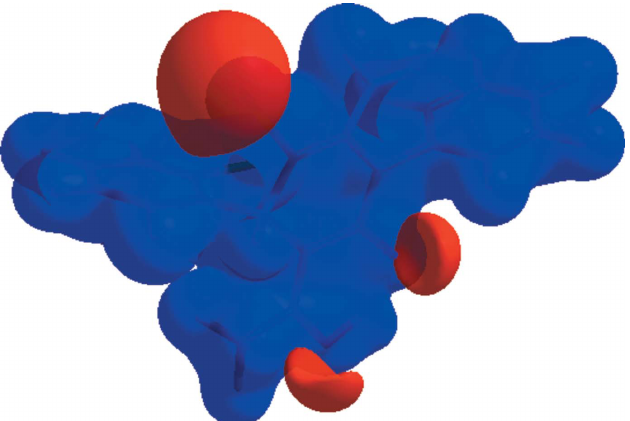
dimensional fingerprint plots generated using Crystal Explorer 17.5 (Turner et al. , 2017). The use of various hues and inten- sities to represent short and long contacts, as well as the relative intensity of the connections, allows Hirshfeld surfaces to depict intermolecular interactions. Fig. 4 shows the three- dimensional Hirshfeld surfaces of the title compound plotted over d (normalized contact distance) in the range of norm (cid:5) 0.4290 to 1.5192 a.u. The red patches that appear around N2 are caused by the intermolecular N3—H3 A (cid:2) (cid:2) (cid:2) N2 and C16— H16 (cid:2) (cid:2) (cid:2) N2 interactions, which are important in the packing of the title molecule. Bright red dots near N2 and amine hydrogen atoms H3 A and H3 B highlight their functions as hydrogen-bonding acceptors and donors, respectively; these also appear as blue and red areas on the Hirshfeld surface mapped over electrostatic potential (Spackman et al. , 2008) in Fig. 5, corresponding to positive and negative potentials.